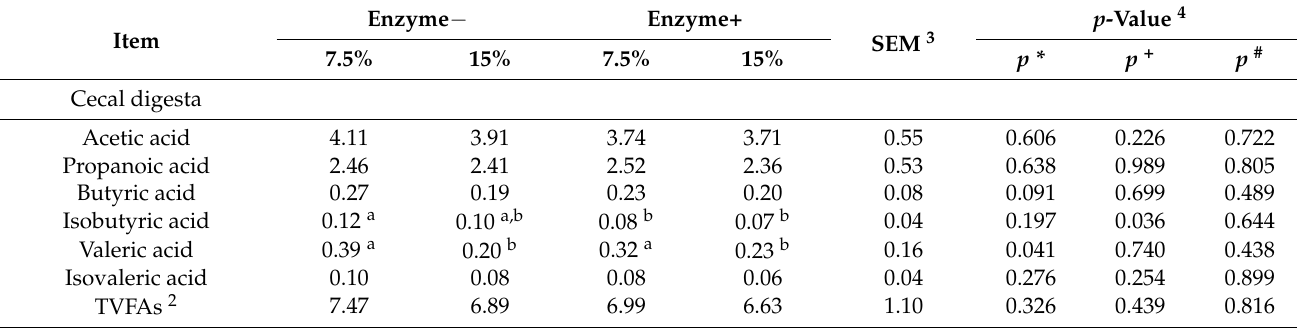
Table 9. Effects of different moisture contents (adding 7.5 vs. 15% water) and enzyme additions (adding 4 kg/t α -amylase or not) to extruded corn on intestinal microbial metabolites ( µ mol/g of wet digesta) in the cecal and colonic digesta of weaning piglets 1